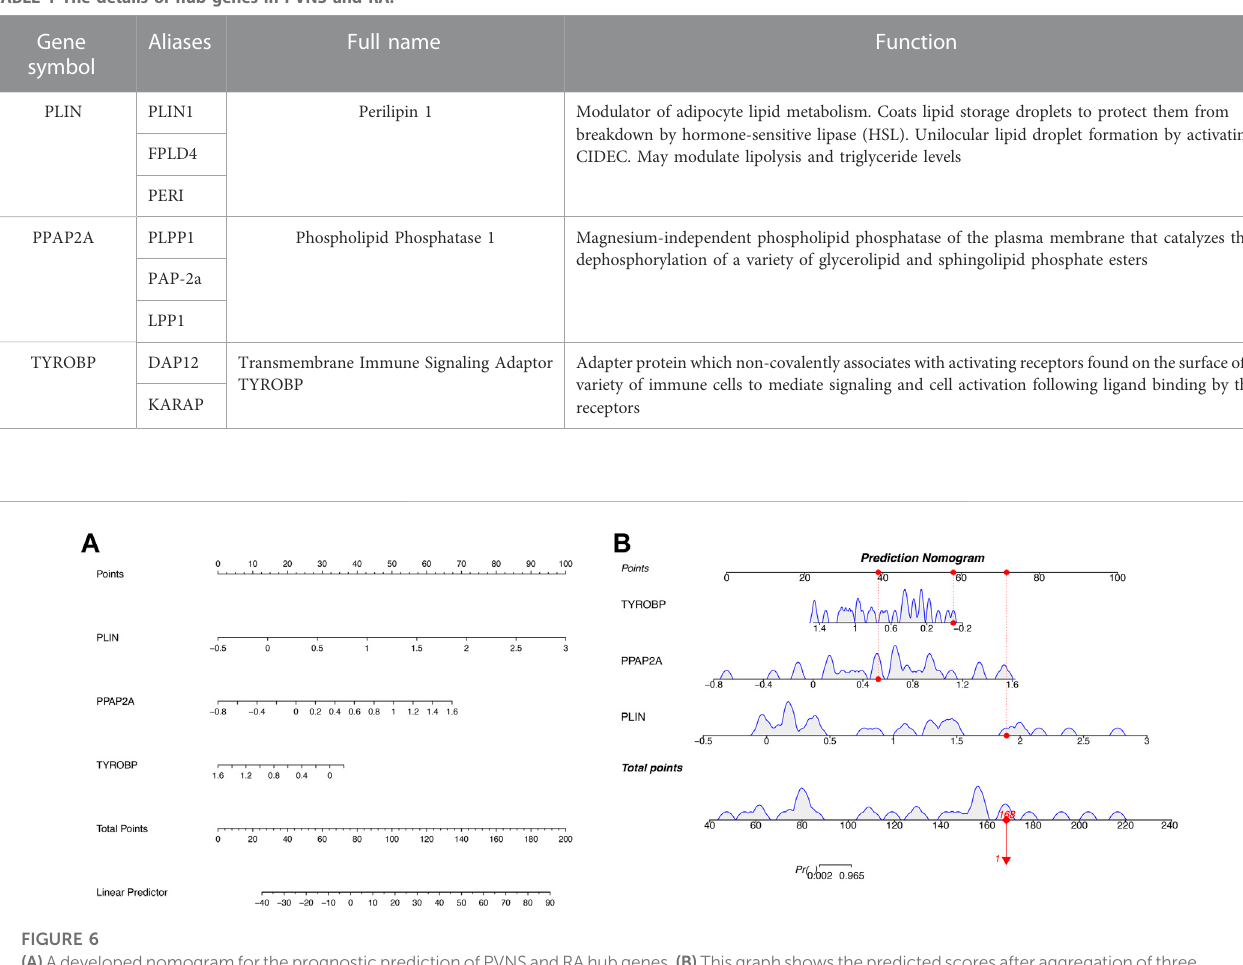
TABLE 1 The details of hub genes in PVNS and RA.